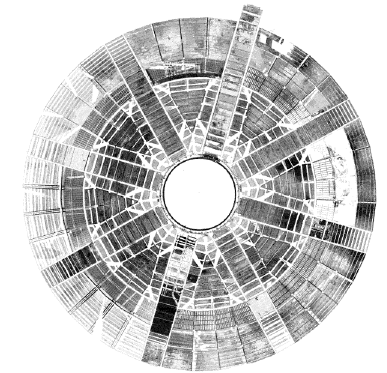
Figure 7. Ortho-image generated from the virtual scan.